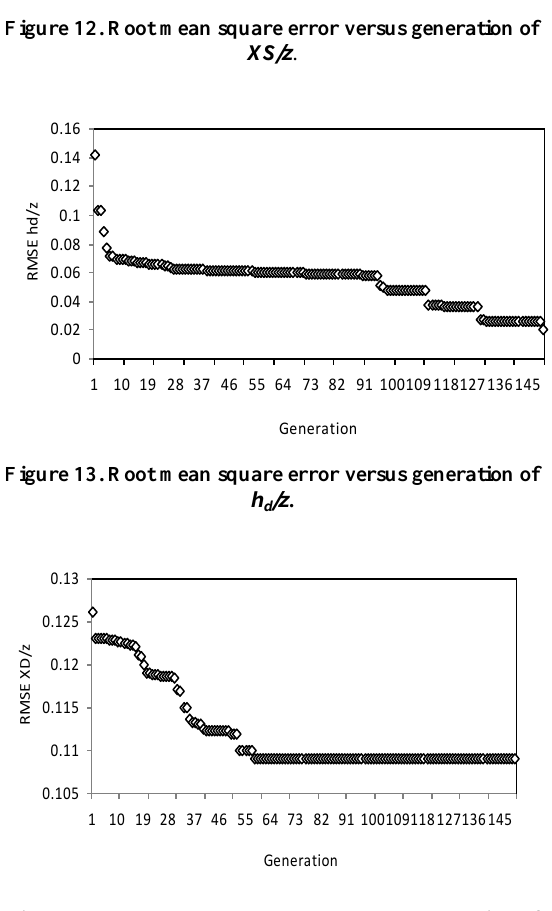
Figure 14. Root mean square error versus generation of XD/z